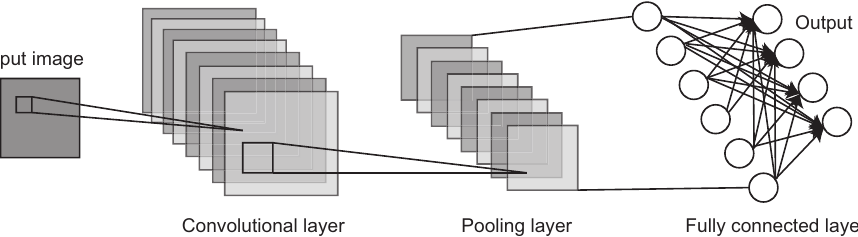
Figure 1. A basic architecture of the Convolutional Neural Network (CNN). A typical CNN is mainly composed of a convolutional layer, a pooling layer and a fully connected